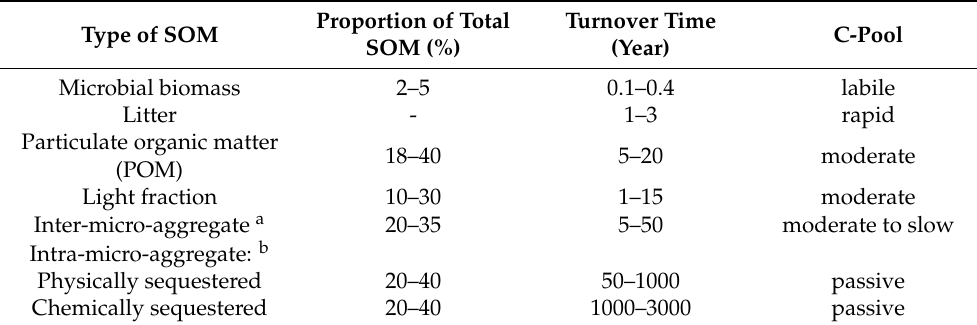
Table 1. Ranges in the amount and turnover times of various types of soil organic matter (SOM) stored in agricultural soils (Source: Batjes